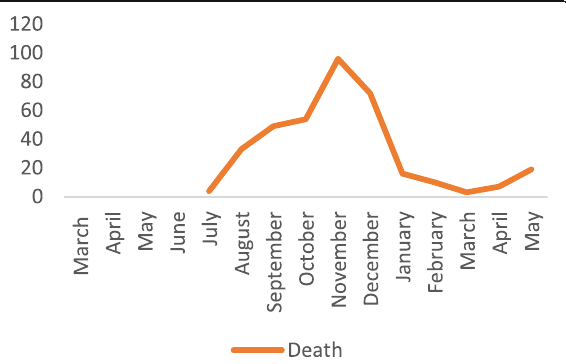
Fig. 2 Number of COVID-19 death from March 2020 to May 2021 as reported by the Ministry of Health in